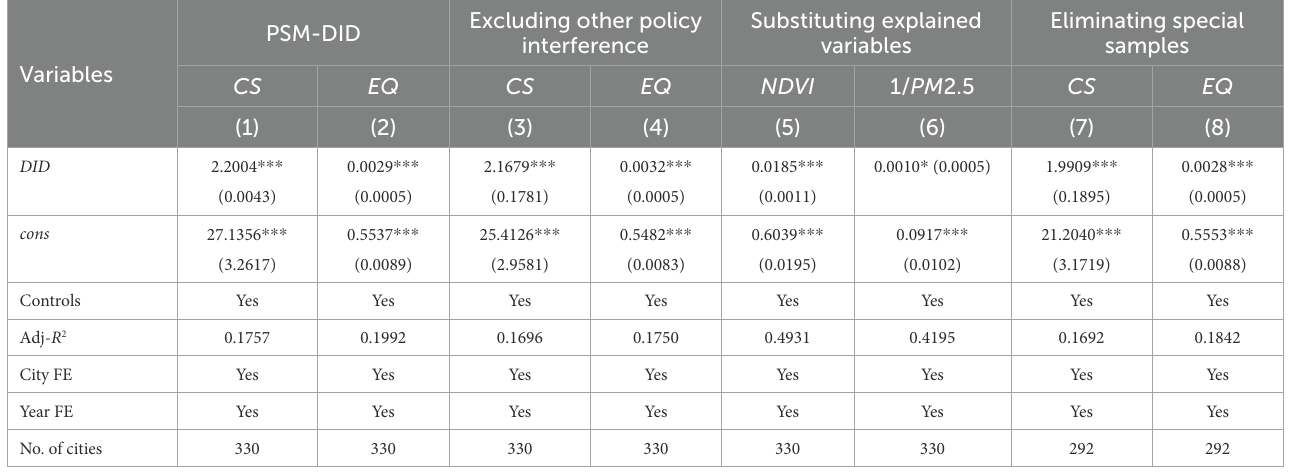
TABLE 3 Robustness